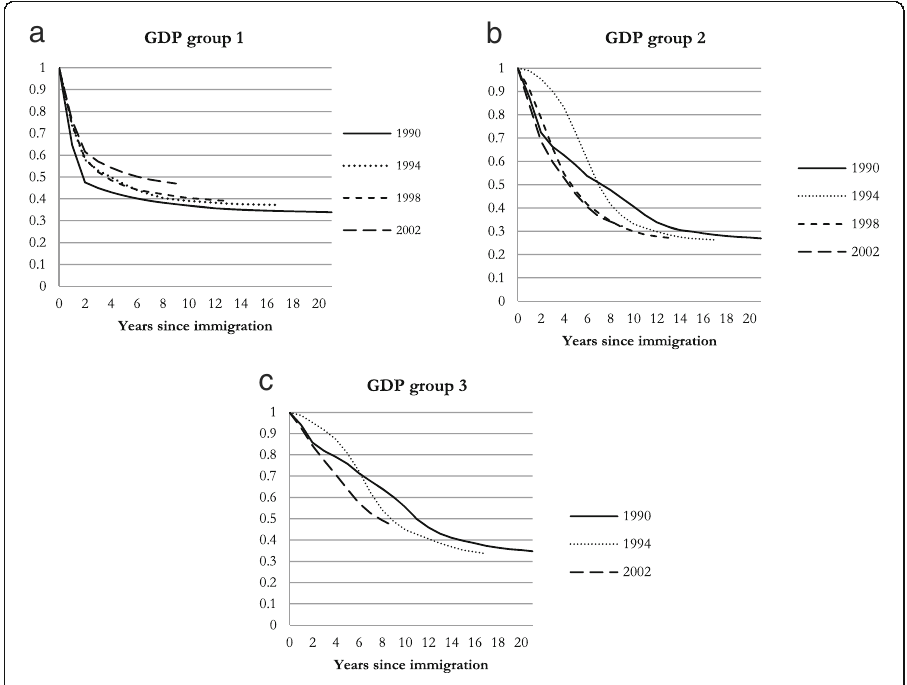
Fig. 4 a – c Life table survival estimates for time until annual income >2 BB by GDP